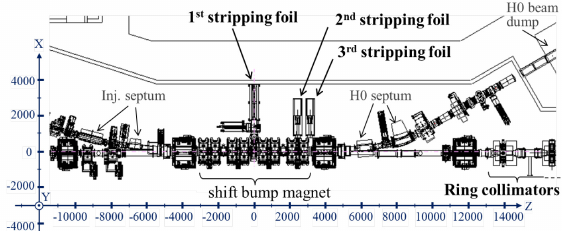
Fig. 3. Top view of injection area in RCS.